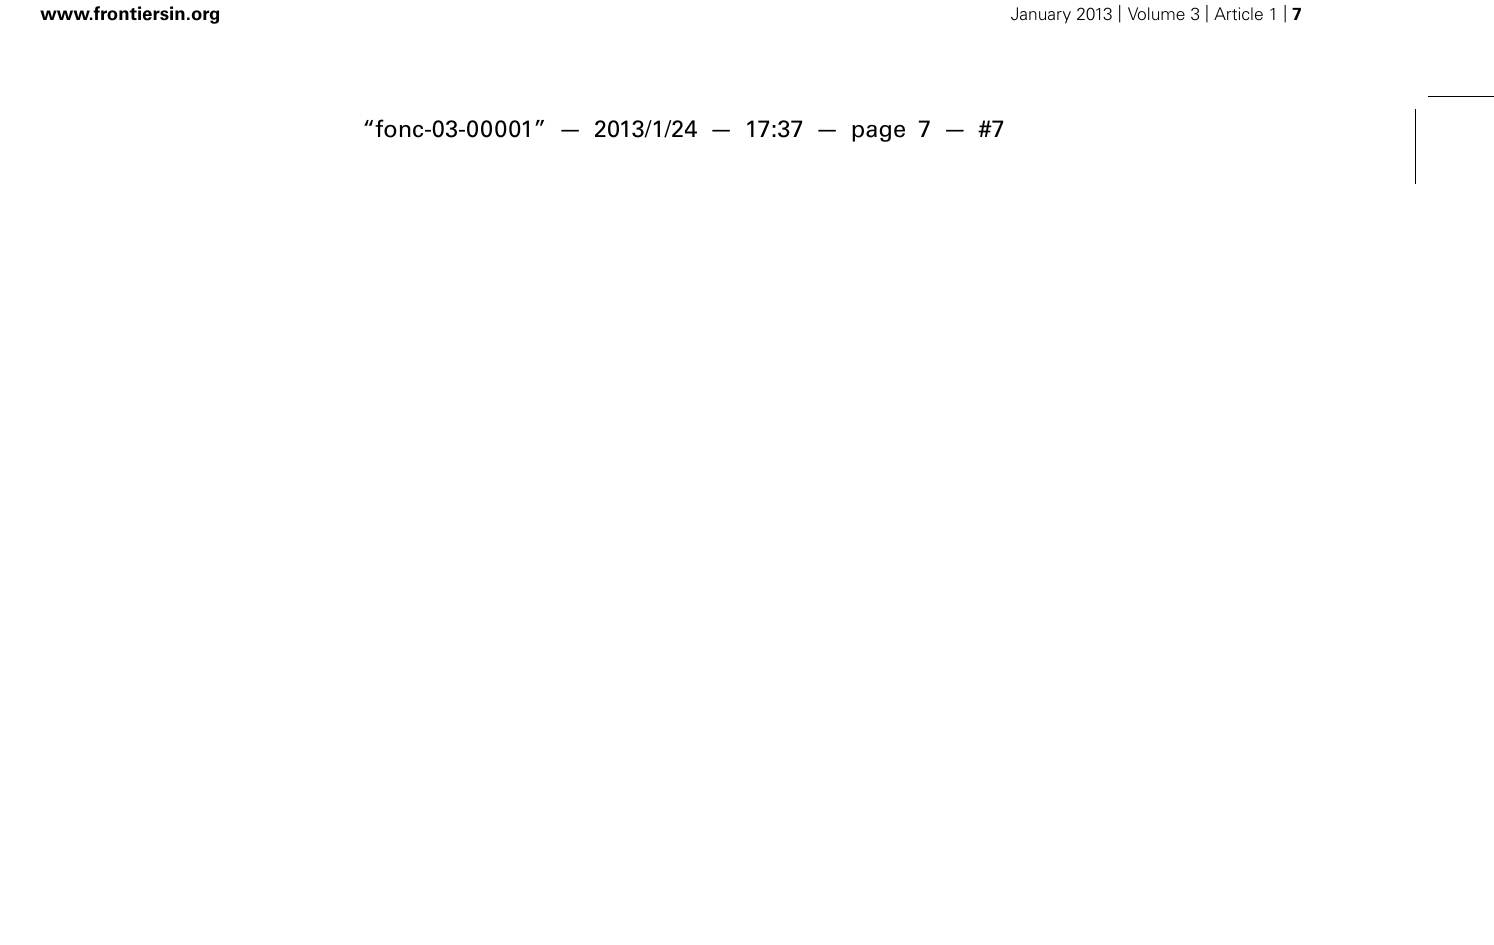
propidium iodide and analyzed by flow cytometry.The data showed percentage of events in sub-G 1 , G 1 , and S/G 2 –M phase. (D) Caspase 3/7 activities were assessed after 48 h with different concentration of DZNep in KCNR cells.The percentage of caspase 3/7 activity was graphed after normalization to non-treated cells. (E) KCNR cells were treated with 5 μ mol/L DZNep in the absence or presence of 100 μ mol/L pan caspase inhibitor, Z-VAD-FMK, for 72 h.The percentage of surviving cells was graphed after normalization to untreated control. (F) Mice were treated with or without DZNep (2.5 mg/kg) twice a day, 3 days per week for 4 weeks. The mean tumor volumes are plotted using the SEM.The time points with significant differences ( P < 0.05) are indicated with an asterisk. Adapted fromWang etal. (2012). © 2012 American Association for Cancer